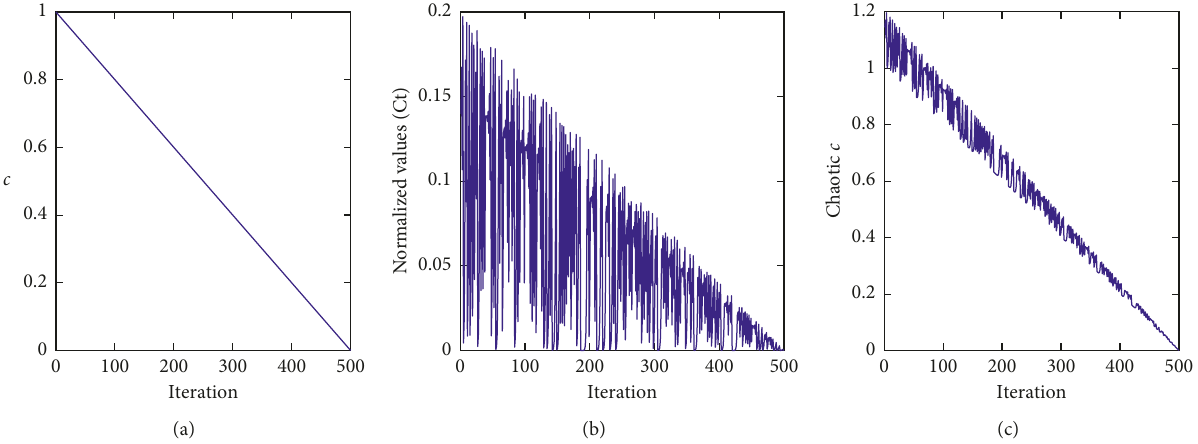
Figure 2: Development of chaotic bridging